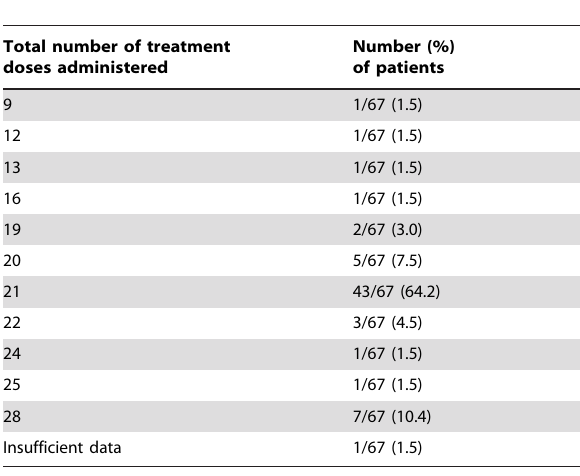
Table 2. Total number of SbV doses received by each of the 67 patients.